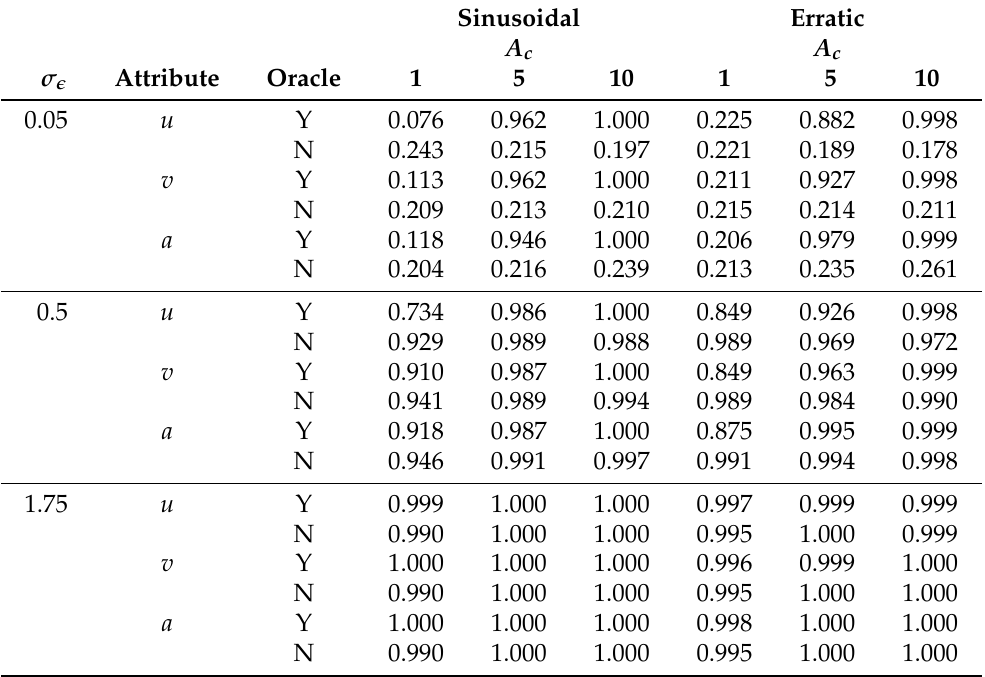
Table 2. Average coverage probabilities of u , v , and a for both Oracle and non-Oracle models. The models were trained on a sinusoidal training system with amplitudes A c = 1,3,5, force error σ (cid:101) = 0.05,0.5,1.75 and validated on both Erratic and Sinusoidal systems with Erratic system with typical validation amplitude of 5, created using Erratic system variances ψ 2 Sinusoidal parameters A p = 5, σ (cid:101) = 0.5. Based on 100